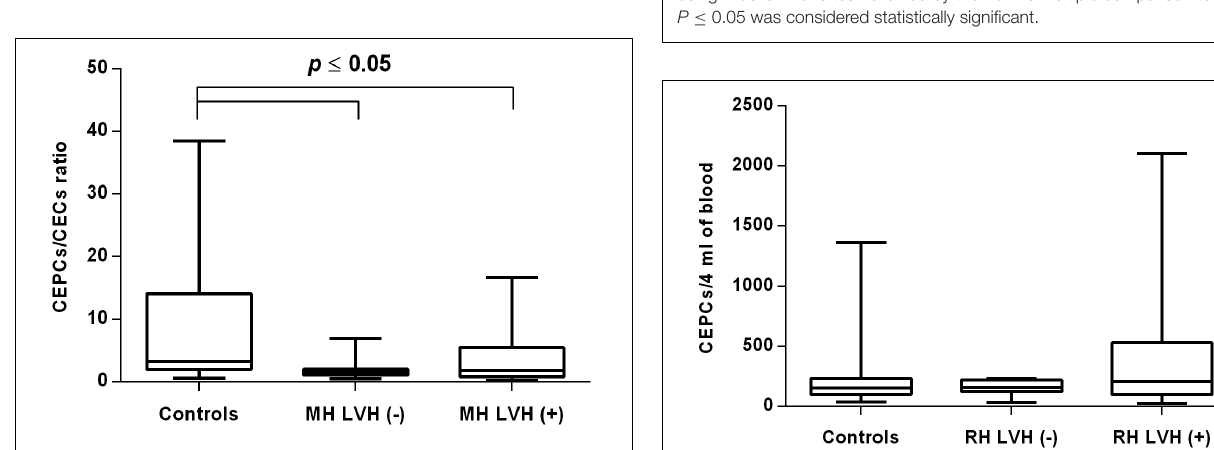
FIGURE 3 | CEPCs/CECs ratio in patients with and without LVH belonging to MH group. Box and whisker plots show median (central line), upper and lower quartiles (box) and range excluding outliers (whiskers). Data were analyzed using Kruskal-Wallis test followed by the Dunn’s multiple comparison test. P ≤ 0.05 was considered statistically significant.